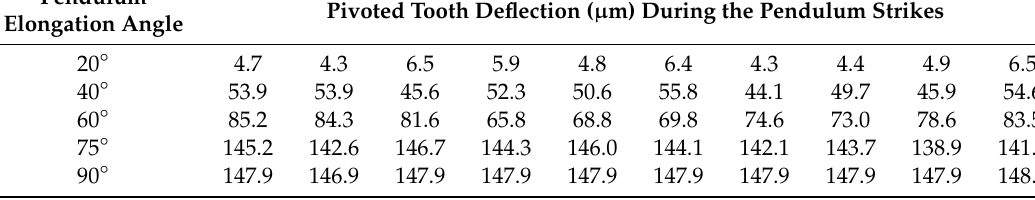
Table 1. NO MOUTHGUARD measurements: Maximum amplitude values of the pivoted tooth elongated root deflection obtained during measurements with energy blows from 20 ◦ –90 ◦ pendulum elongation angles (ten pendulum hits performed from every